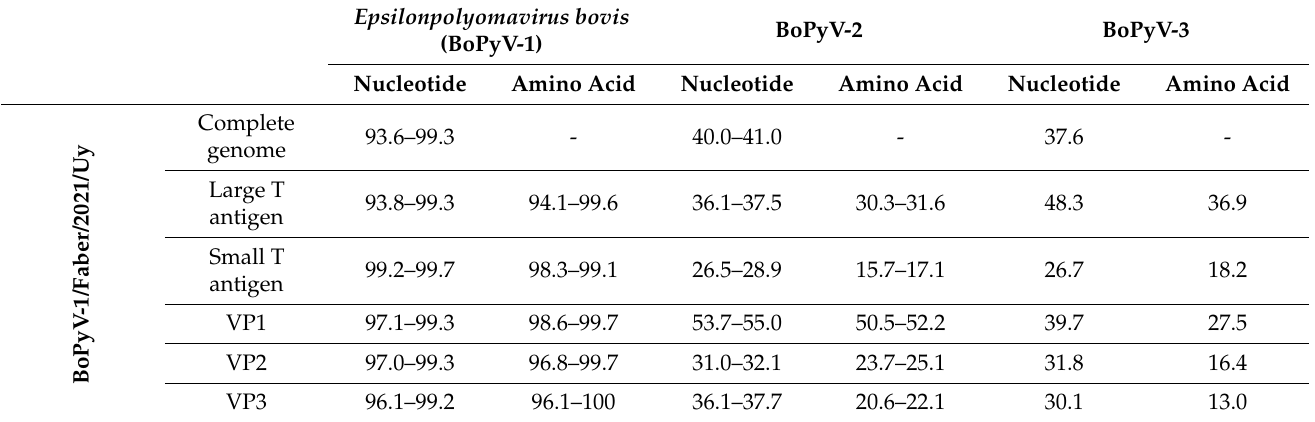
Table 1. Comparison between BoPyV-1/Faber/2021/Uy and members of the Epsilonpolyomavirus bovis (BoPyV-1), BoPyV-2, and BoPyV-3 at the nucleotide and amino acid levels. Epsilonpolyomavirus bovis BoPyV-2 BoPyV-3 (BoPyV-1) Nucleotide Amino Acid Nucleotide Amino Acid